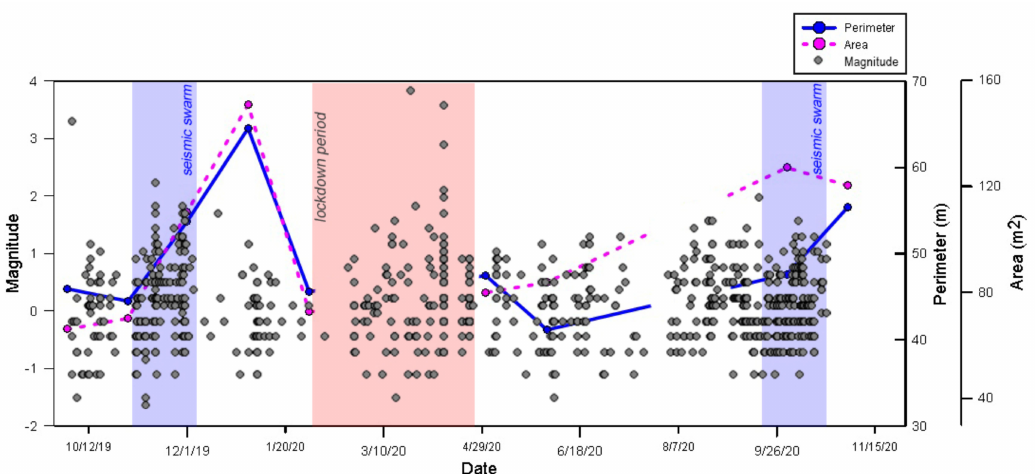
Figure 16. Comparison between the local earthquakes as well as the perimeter and area of the bubbling mud pool as a function of